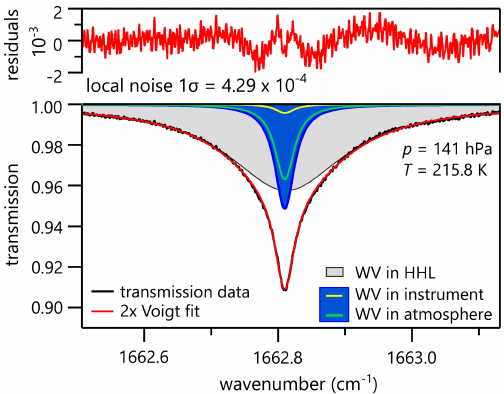
Figure 8. Representative transmission spectrum recorded during balloon-borne deployment at 13.8km altitude. The spectrum ex- hibits two spectroscopically distinguishable features: a broad ab- sorption (gray) due to the enclosed water vapor within the laser housing HHL (OPL of 3mm) at ca. 1000hPa and a narrow ab- sorption (blue) at a pressure of 141hPa. The latter feature is again a superposition of two contributions: the atmospheric absorption (green) within the MPC (OPL of 6m and T = 215 . 8K) as well as the absorption by trapped water vapor within the instrument’s en- closure, which is not distinguishable spectroscopically